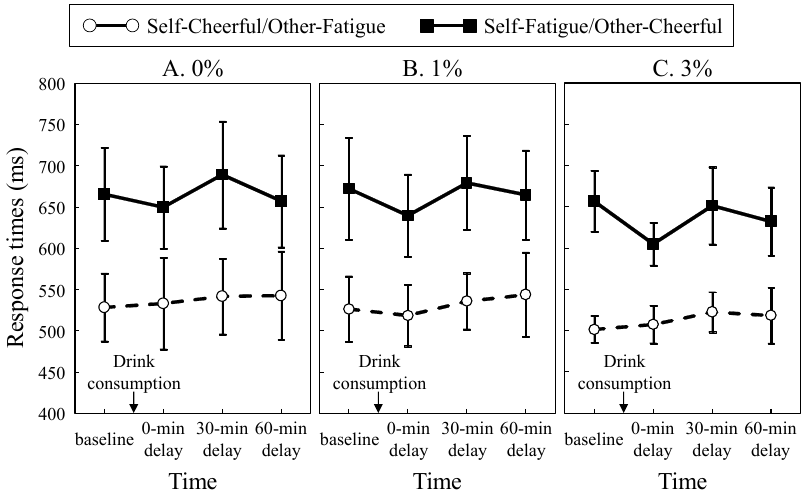
Figure 2. Mean reaction times of correct trials for each alcohol concentration (A: 0%, B: 1%, and C: 3%) and the two critical blocks (Blocks 4, self—cheerful/other—fatigue; and 7, self—fatigue/other—cheerful) as a function of time (baseline, 0, 30, and 60 min delay). Error bars show 95% confidence interval.